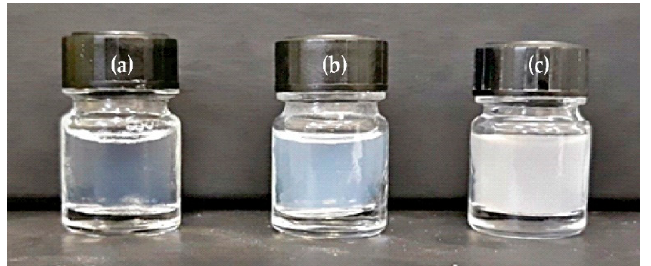
Figure 11. Visual aspects of the micellar solution of the PNVCL- b -PCL (1) block copolymer (C = 0.5 mg mL − 1 ) at different temperatures, at around: ( a ) 19 °C, ( b ) 29 °C and ( c ) 40 °C.